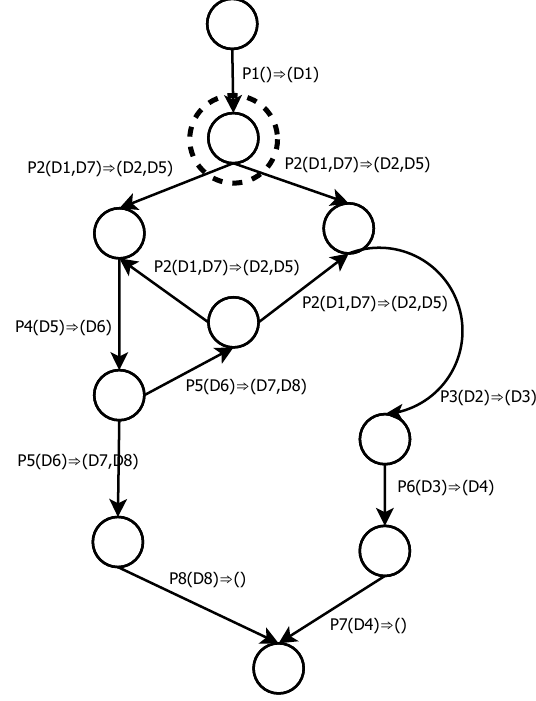
Fig. 15. FSM of sample business process diagram.